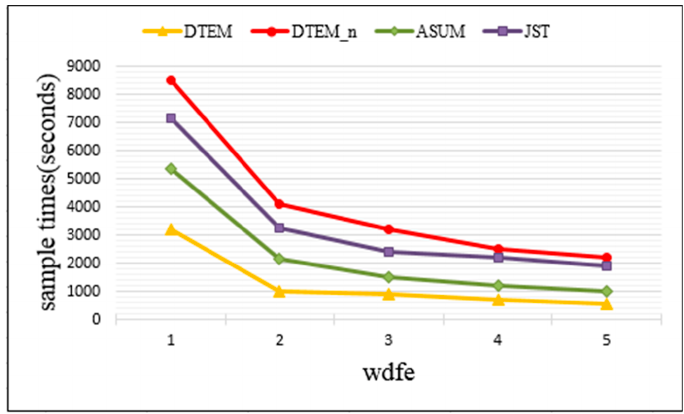
Figure 6. Occurrence of different words.